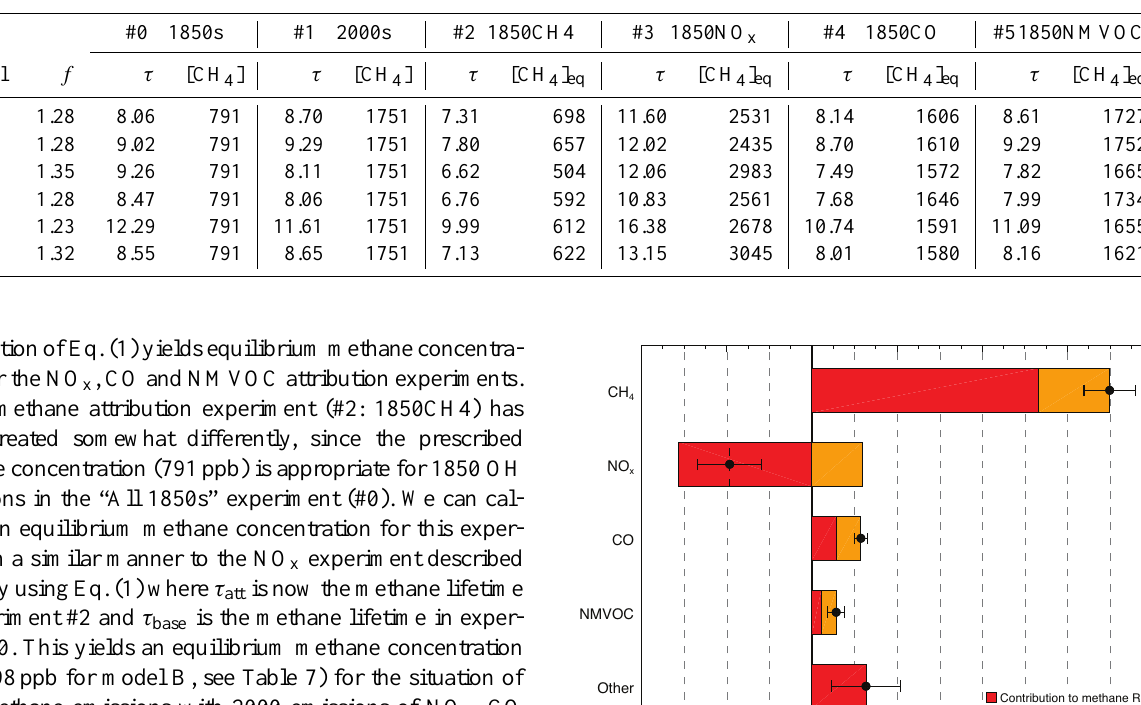
Table 7. Methane adjustment factors ( f , dimensionless), whole-atmosphere lifetimes ( τ , yr), from attribution experiments, and corresponding equilibrium methane concentrations (ppb), calculated using Eq. (1), for experiments #2–5. For experiments #0–1, we show observed imposed methane values.